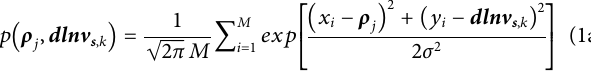
Figure 2. The gravity data domain has